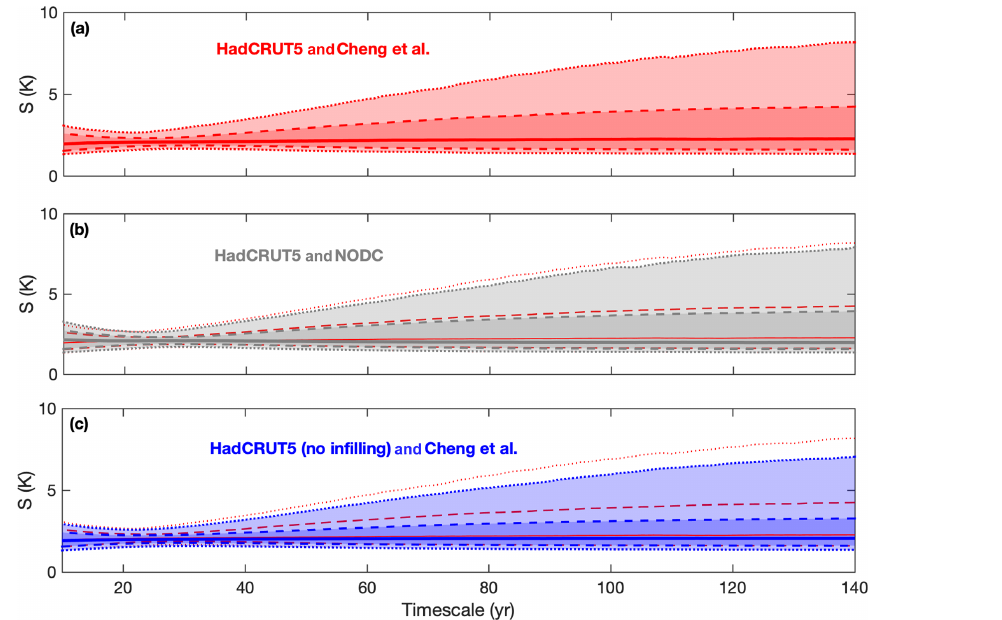
Figure 4. Climate sensitivity ( S ) from 10- to 140-year response timescales following a 4 × CO 2 forcing scenario constrained by different combinations of observational reconstructions. Solid lines show the median, dashed lines and dark shading show the 66% range (17th to 83rd percentiles), and dotted lines and light shading show the 95% range (2.5th to 97.5th percentiles). Panels (a) , (b) , and (c) show results from posterior model ensembles constrained by different dataset combinations, where red lines on panels (b) and (c) give a comparison to HadCRUT5 and Cheng et al.